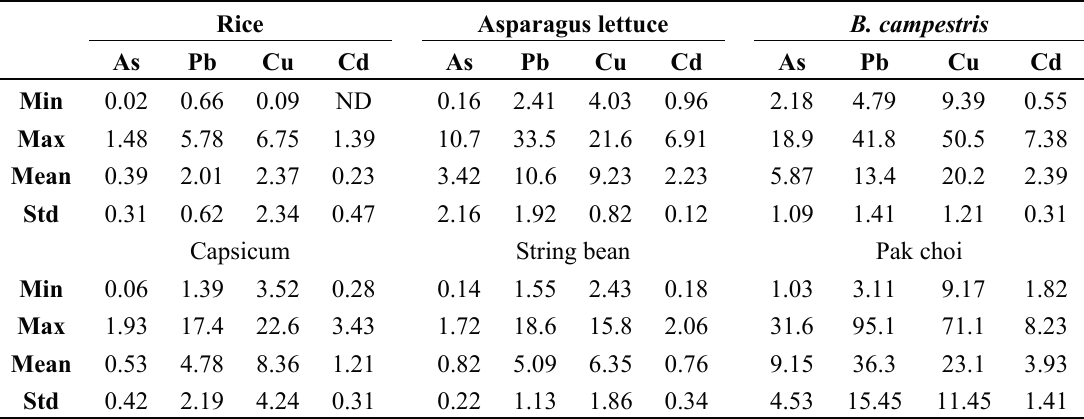
Table 5. Heavy metal concentrations in crop samples (mg/kg d.m.). Rice As Pb Cu Cd As Pb Cu Cd As Pb